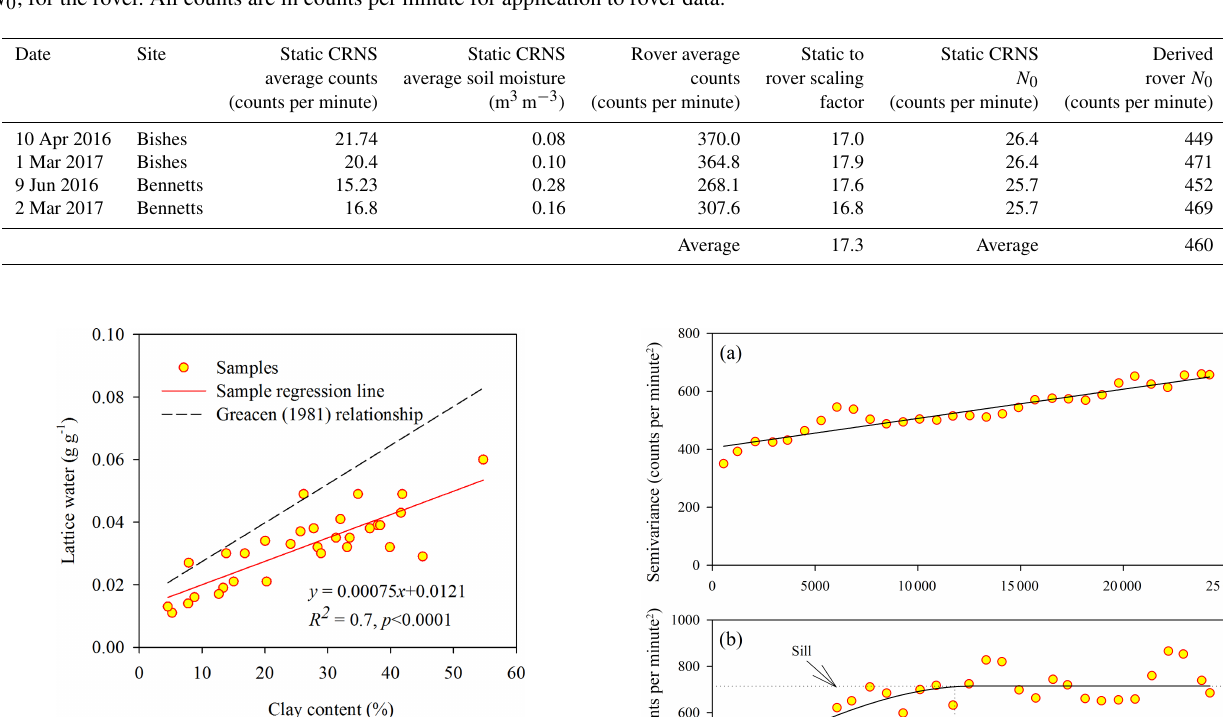
Table 1. Side-by-side comparison of average neutron counts for the static CRNS’s (Bishes and Bennetts) and the rover for four different 12h periods. Also shown are the average soil moisture values for each date, static CRP to rover scaling factors and derived dry soil counting rate, N 0 , for the rover. All counts are in counts per minute for application to rover data.